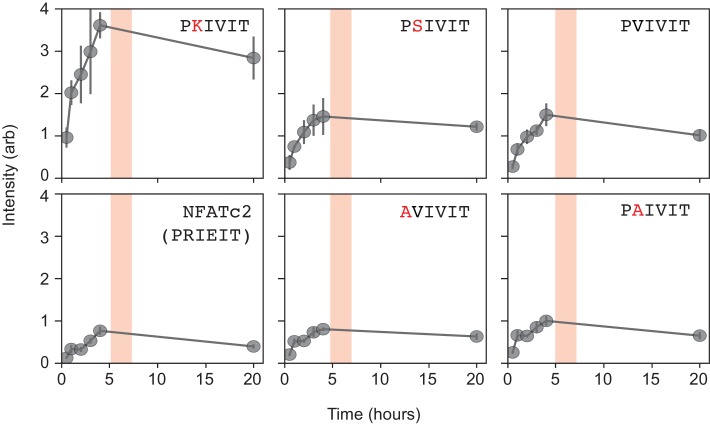
Time-dependent measurements of calcineurin binding demonstrating that calcineurin-MRBLE on-rates are slow.Measured intensities (grey dots with interpolated line) for 6 PxIxIT variant peptides (PKIVIT, PSIVIT, PVIVIT, NFATc2, AVIVIT, and PAIVIT) as a function of time for a reaction concentration of 0.25 μM calcineurin. Intensities appear to saturate at 5–6 hr and decrease only slightly after 24 hr. Pink boxes signify the time window for all subsequent measurements.